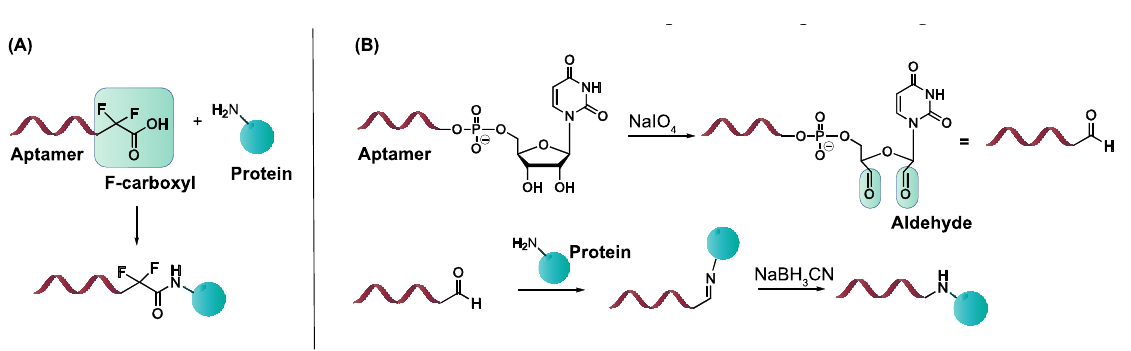
Figure 17. Templated directed ligation with an F-carboxyl-modified aptamer ( A ) and an aldehyde- Templated directed ligation with an F-carboxyl-modified aptamer ( A ) and modified aptamer ( B ). an aldehyde-modified aptamer ( B